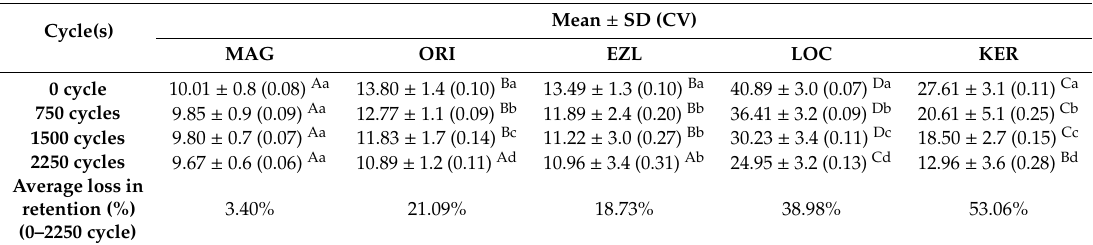
Table 2. Mean (N), Standard deviation (SD), and Coe ffi cient of Variation (CV) of retentive forces observed in the insertion–removal cyclic